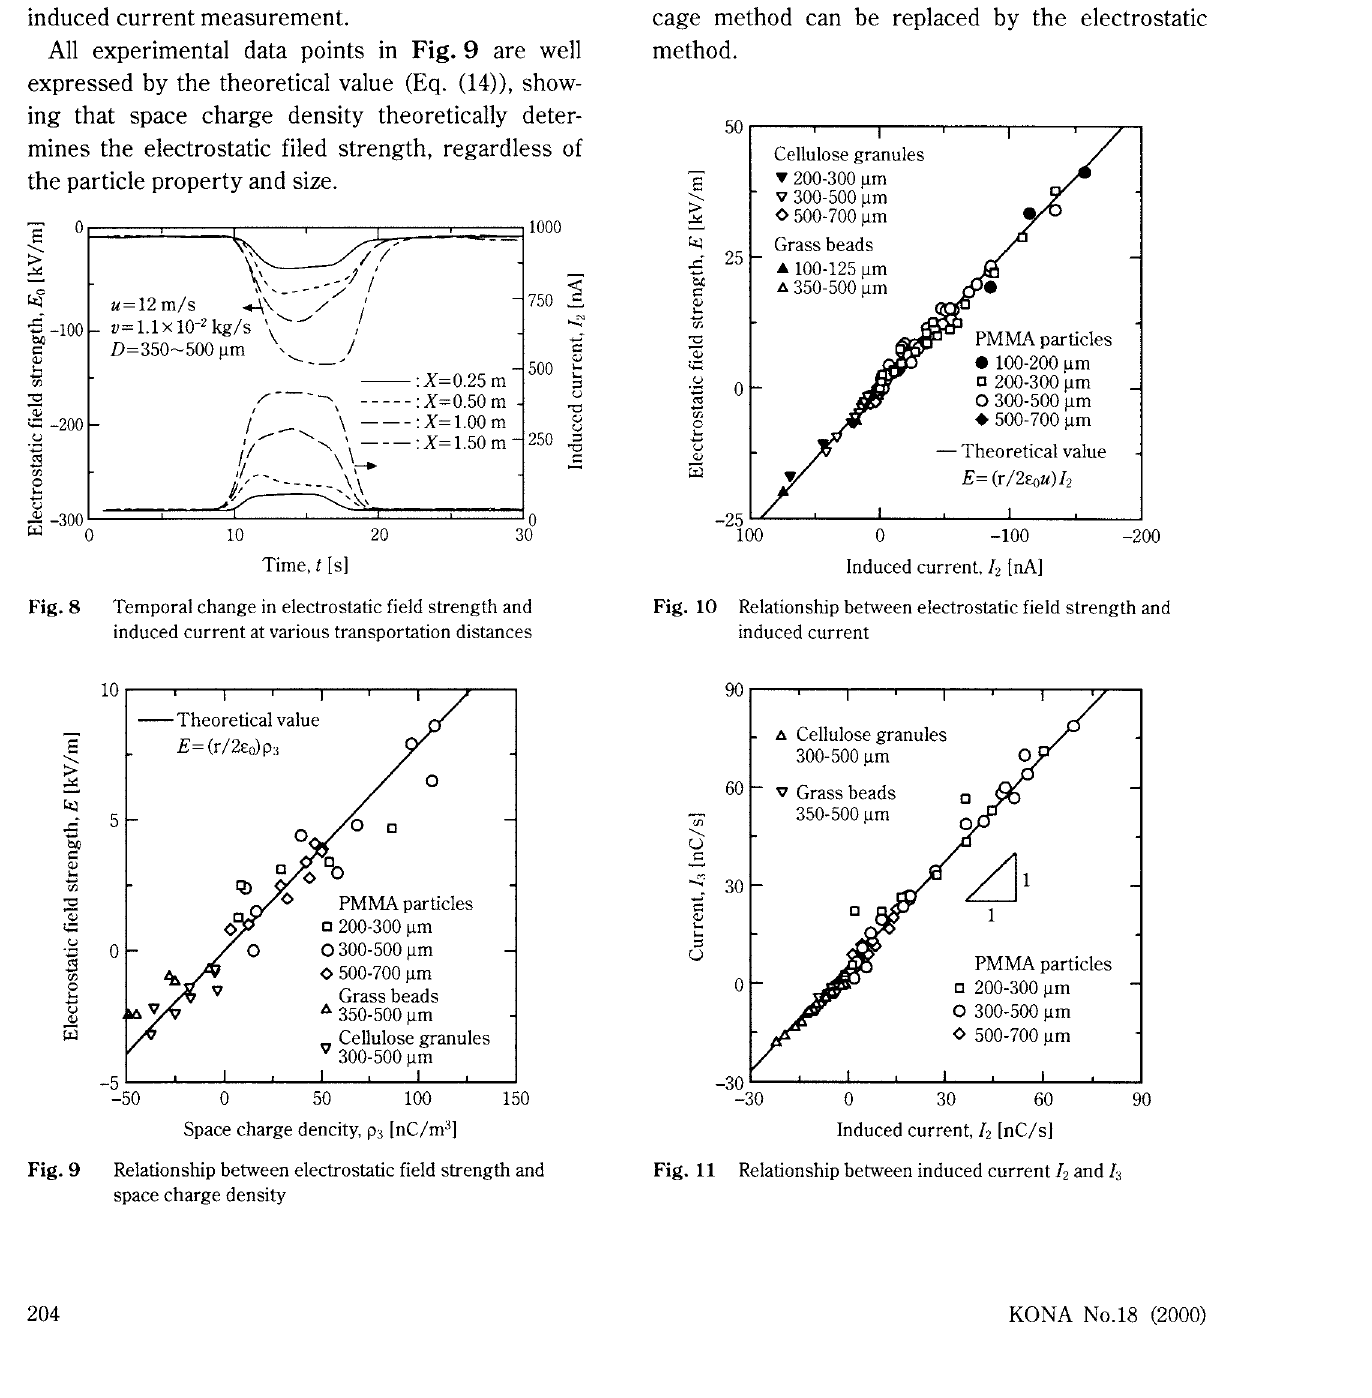
Relationship between electrostatic field strength and space charge density